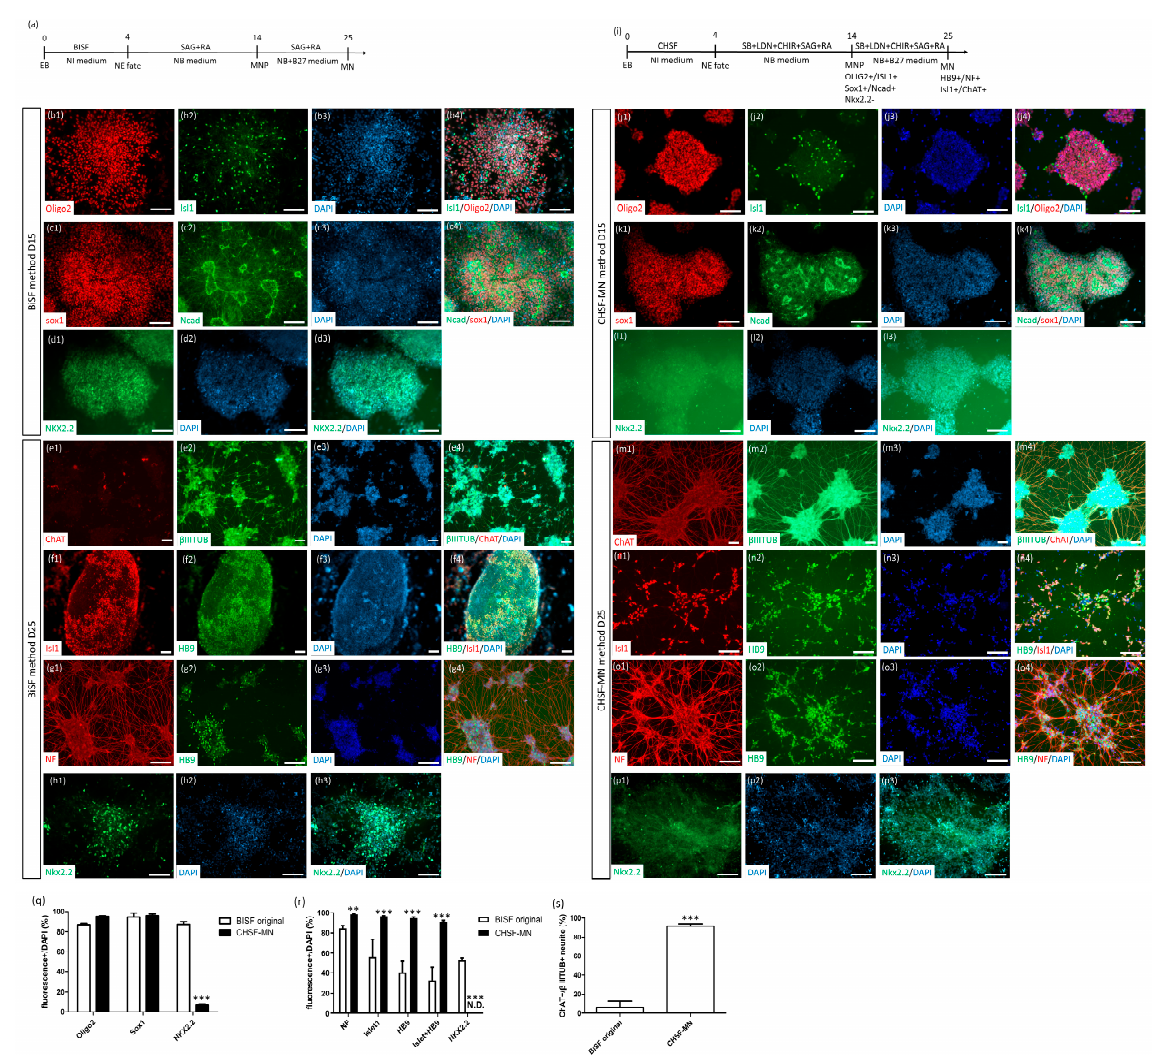
Figure 1. CHSF-MN protocol improved the MN generation ability and stability of the BiSF protocol. ( a ) Procedure of BiSF-based MN differentiation. ( b – h ) Identification of SOD1 G85G iPSC line-derived MNPs and MNs via the BiSF protocol using neural stem cell markers (Sox1 and N-cadherin), MNP markers (Oligo2 and Islet1), and an interneuron marker (Nkx2.2) on day 15 and MN (HB9, Islet-1, and ChAT) and neuronal (NF and β -III-tubulin) markers on day 25 of differentiation. ( i ) Procedure